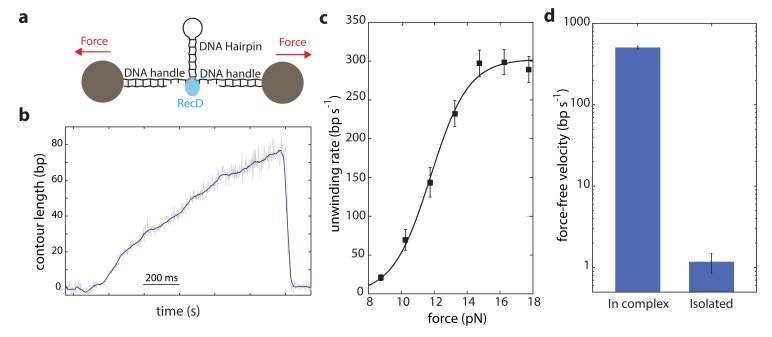
Unwinding of a hairpin under tension by the isolated RecD.(a) Schematic representation of RecD unwinding in optical tweezers. (b) Representative unwinding trace. Raw data is shown in grey, filtered data (fc = 250 Hz) is shown in blue. [ATP] = 2 mM. (c) Velocity-force curve for the isolated RecD at 2 mM ATP follows a sigmoidal-like behavior saturating at high forces. Data shown as mean ± s.e.m., number of traces in Supplementary file 4. The line through the data is a best fit to Equation S29, Supplementary file 3. (d) Force-free velocities for RecD, obtained from (c) and Figure 2b by extrapolating to F = 0, show ~ 2–3 orders of magnitude difference between the enzyme in-complex and the isolated one (Extrapolated result ± s.e.).